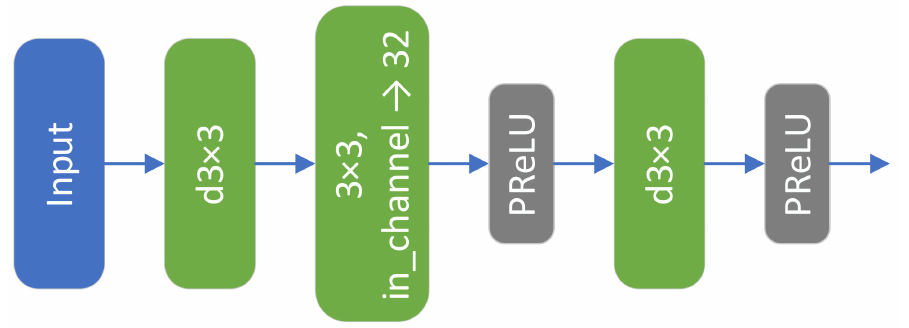
Figure 2. Detailed structure of the stem block; d denotes depthwise convolution. The two-stem structure consists of two stem blocks, each consisting of a layer, a ( · ) denotes a depthwise convolu- Conv 3,32 ( · ) layer, and a DWConv 3,32 ( · ) layer. DWConv f , n tional layer with a size f × f convolutional kernel and n channels, Conv f , n ( · ) denotes a nor- mal convolutional layer with a size f × f convolutional kernel and n channels, and δ ( · ) de- notes the PReLU activation function. In addition, f MS and f PAN denote the extracted LRMS image and PAN image features, respectively; and ⊗ denotes the concatenate